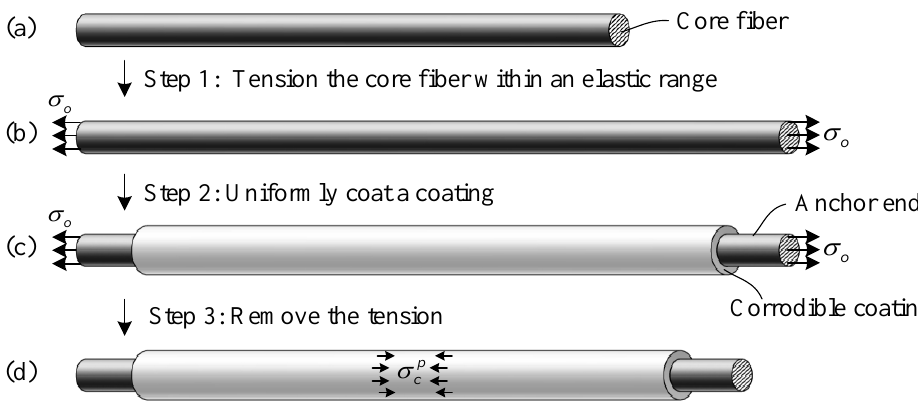
Figure 1. Schematic diagram of preparation process of the corrosion-induced intelligent fiber (CIF), ( a ) unstressed core fiber, ( b ) pre-tensioned core fiber, ( c ) pre-tensioned core fiber coated with an unstressed corrodible coating, ( d ) CIF in equilibrium with core fiber in tension and corrodible coating in compression.